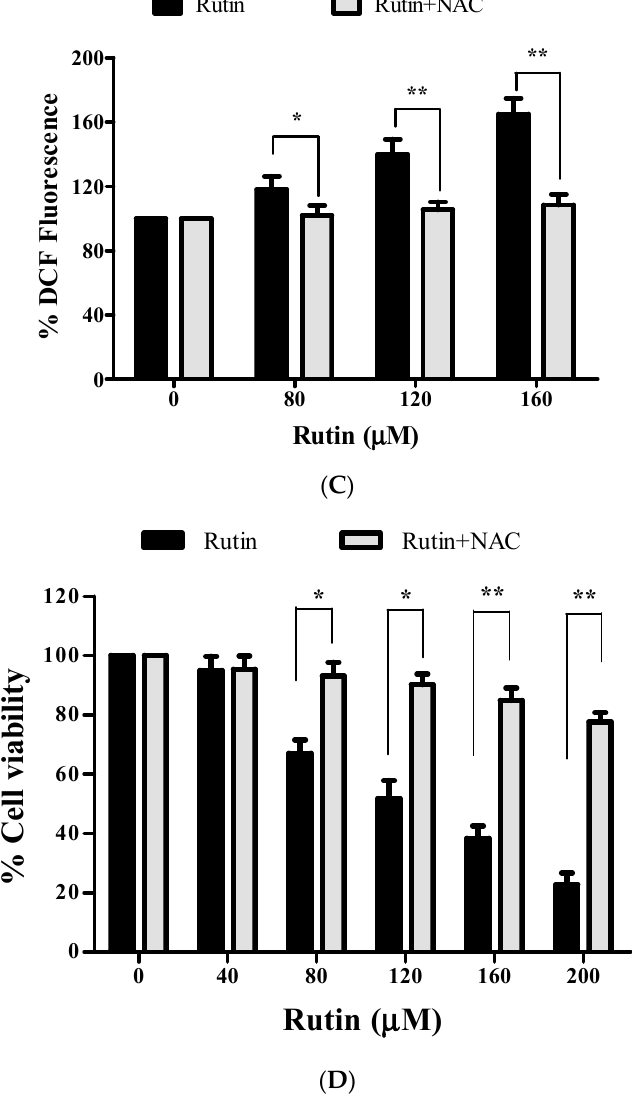
Figure 6. Rutin significantly induces ROS-mediated apoptosis in cervical cancer cells. ( A ) Increased level of ROS generation in rutin-treated SiHa cells stained with by DCFDA staining and examined by fluorescence microscopy. ( B ) Quantification of enhanced percentage of DCFDA fluorescence in rutin-treated SiHa cells. ( C ) Comparative analysis of ROS generation in SiHa cells pretreated with a NAC (ROS inhibitor) and then with different concentrations of rutin. ( D ) Percent cell viability of SiHa cells pretreated with NAC and then with rutin for 24 h assessed by MTT assay. The results are represented as mean ± SEM of three independent experiments (* p < 0.01, ** p < 0.001 compared with control group).